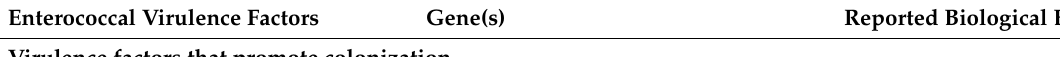
Table 3. Enterococcal virulence determinants and their putative